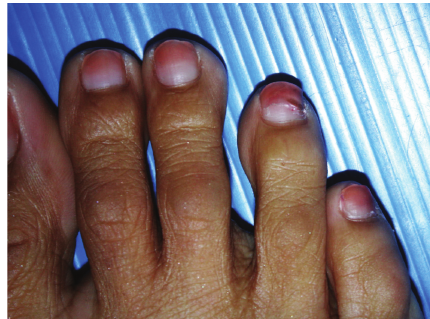
Figure 1: Proximal separation of the right 4th toenail.